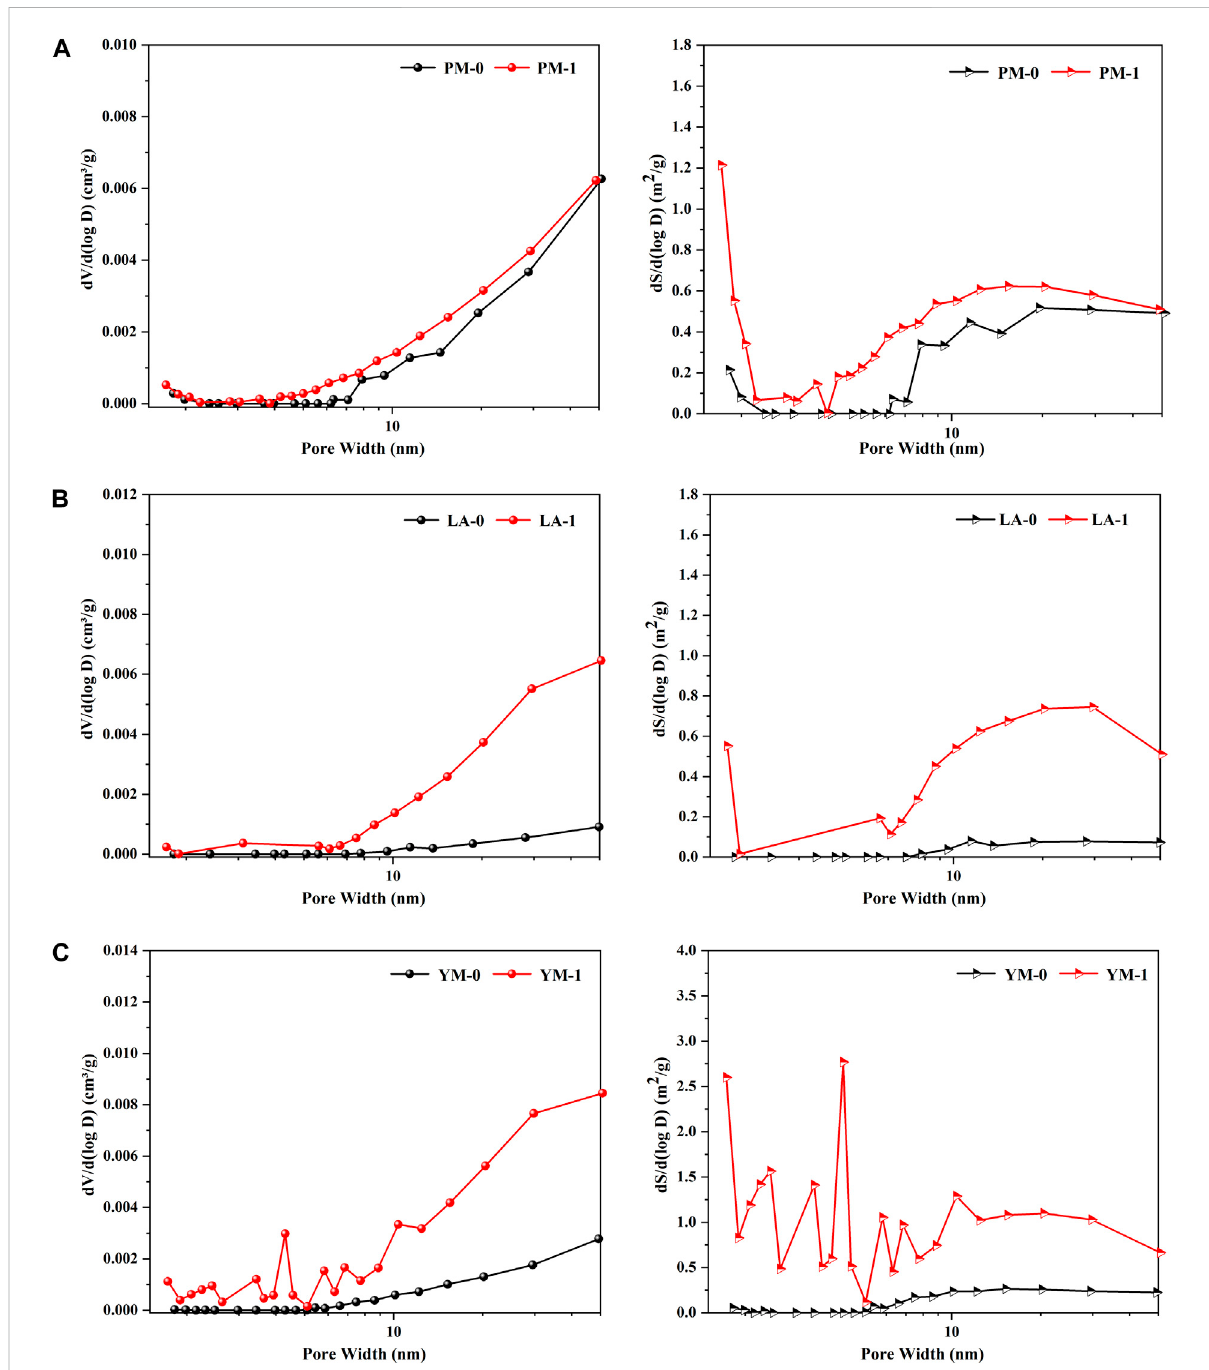
FIGURE 4 Mesopore volume distribution curves and mesopore area distribution curves from the LTGA-N 2 measurement: (A) PM; (B) LA; (C) YM.